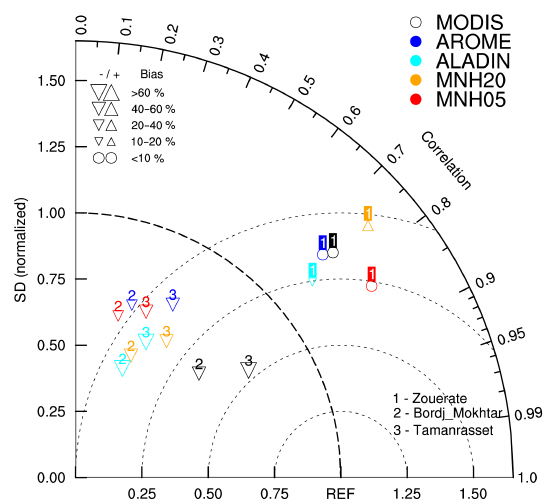
Figure 4. Taylor diagram showing normalized standard deviations (radius) and correlation (cosine of angle) of AOD with respect to those of the AERONET observations. The size of symbols varies with the bias relative to AERONET AOD values averaged at each station. For each model, the station number in which the bias is minimum is set in a